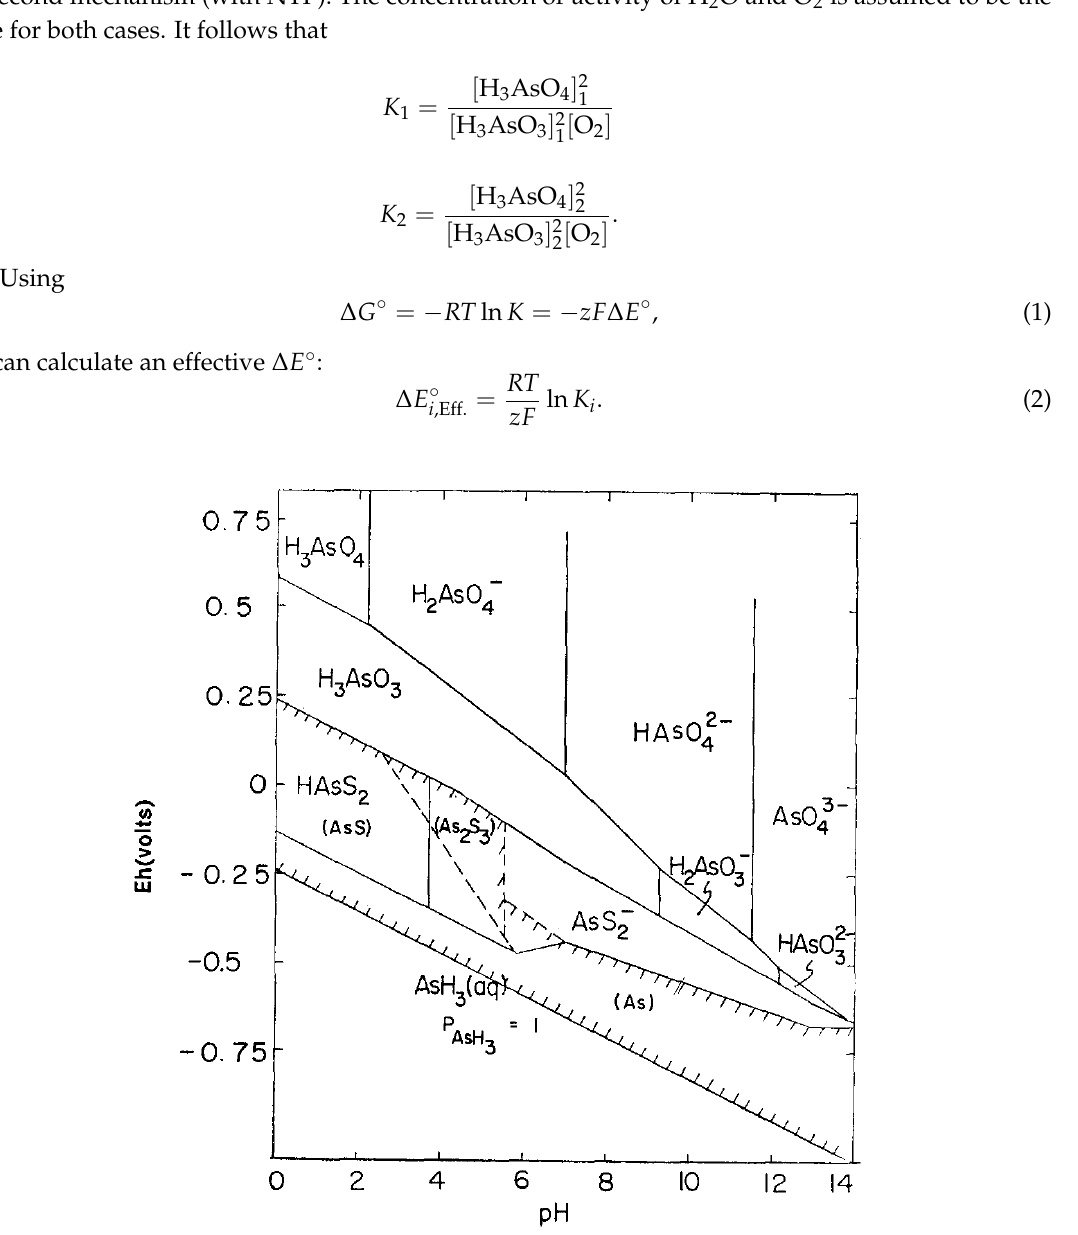
TABLE 1. FREE ENERGIES OF FOR.MATION FOR ARSENIC SPECIES AT 25°C, AND ONE